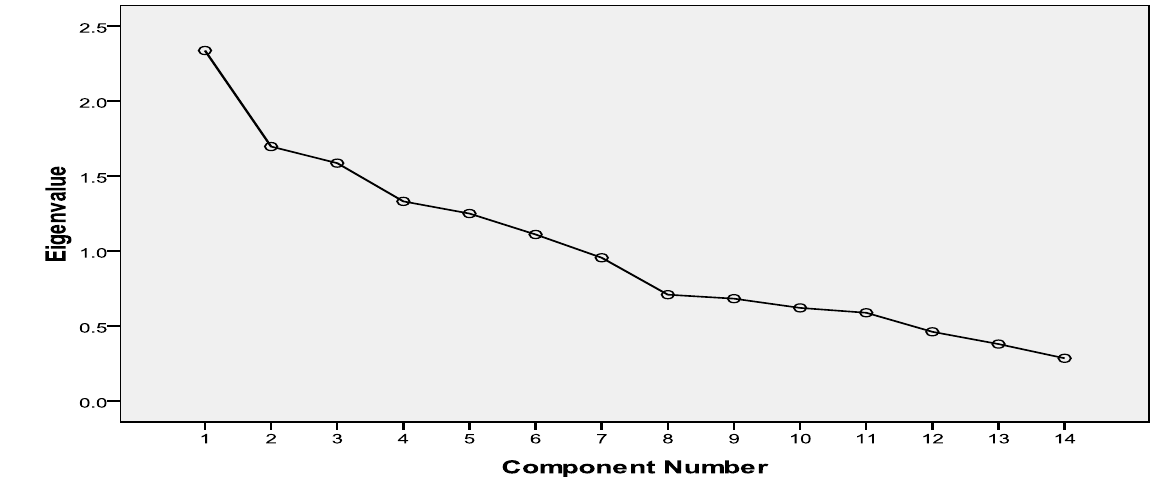
Figure 1 Scree Plot Graph of Eigen